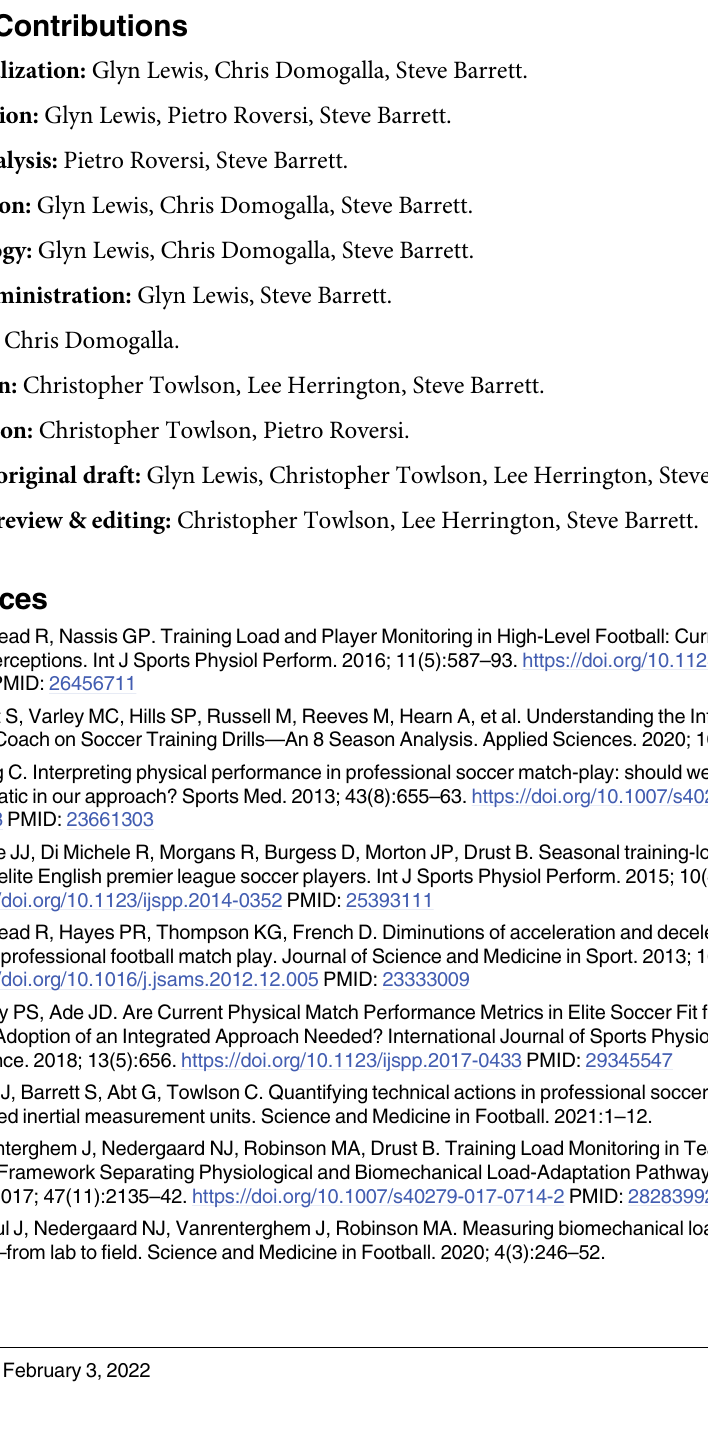
S1 Table. The six categories of training drill utilised in the training programme, with cor- responding operational definitions